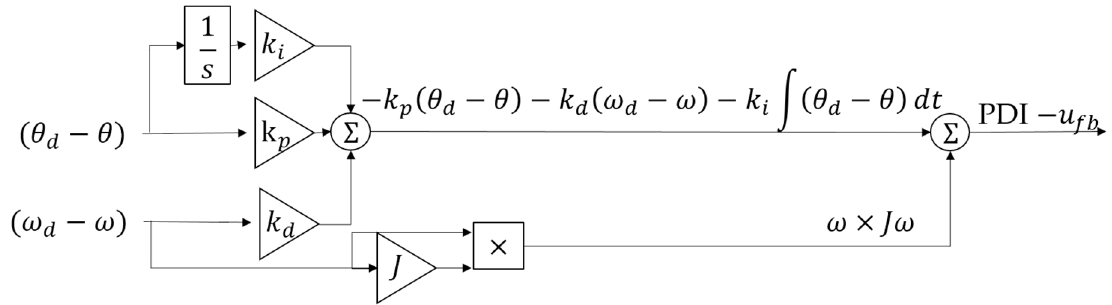
Figure 2. Nonlinear-enhanced PDI controller with desired ω d input to remove virtual zero reference scaled by K p , K d , and K i gains. Also notice the nonlinear cross product ω × J ω enhancement.